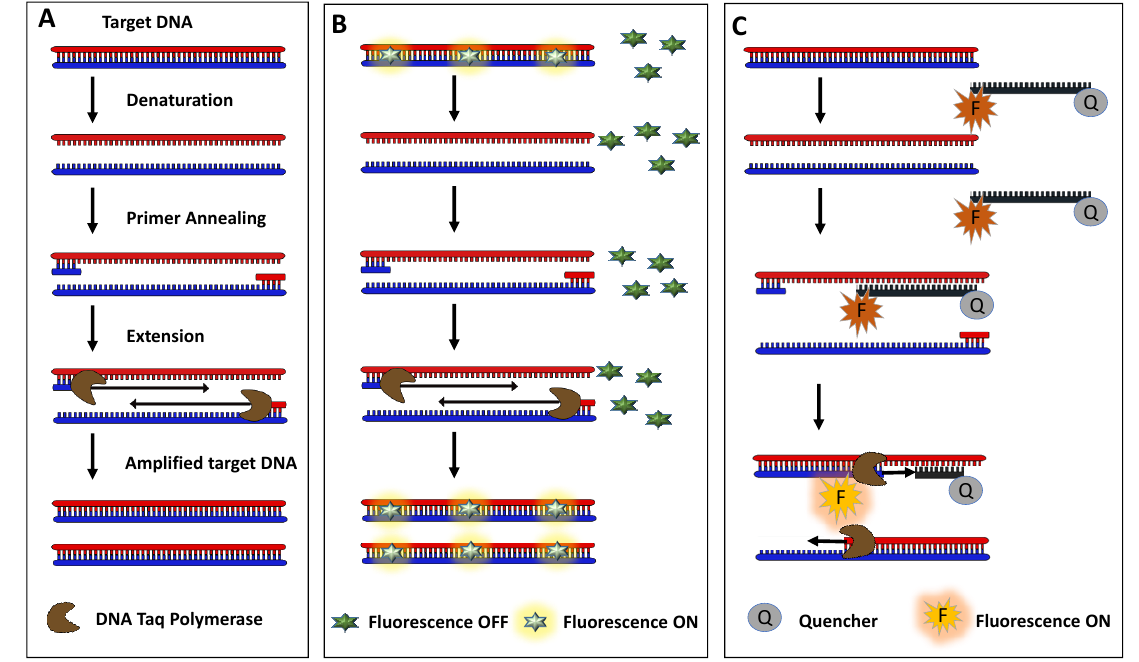
Figure 2. Working mechanism of polymerase chain reaction (PCR): ( A ) a standard PCR cycle, ( B ) schematic of a quantitative PCR (qPCR) where deoxyribonucleic acid (DNA) intercalating dye is used for the quantification of amplified DNA, and ( C ) schematic of a qPCR cycle where DNA probes such as molecular beacon is used to detect the amplification in real time.